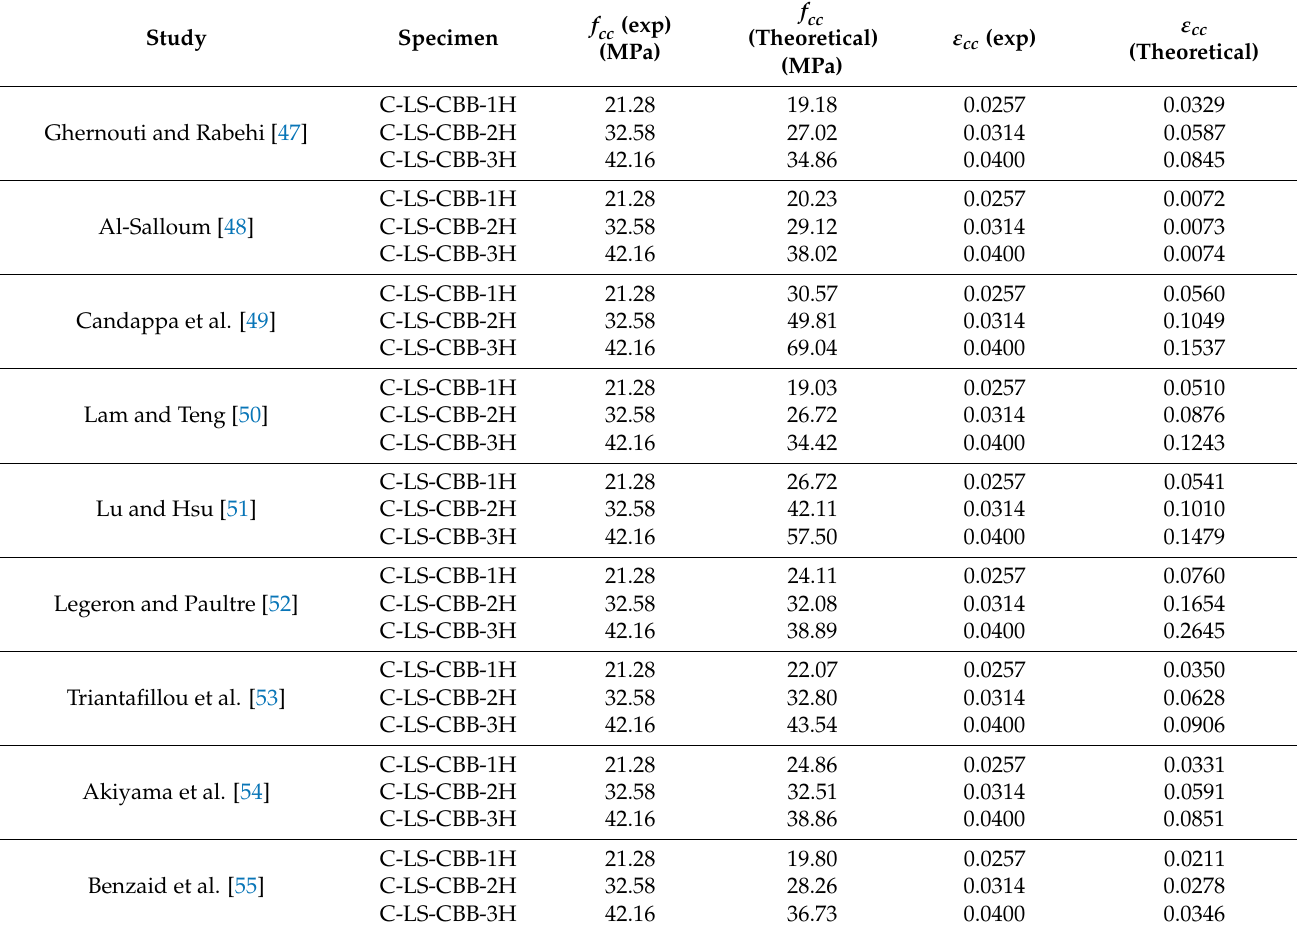
Table 6. Comparison of experimental and analytical results for confinement of Type-1 concrete group.